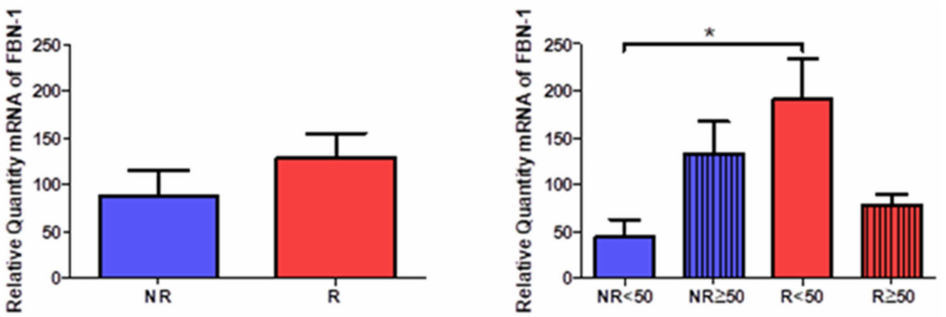
Figure 13. Protein expression of fibulin 5 in NR < 50 ( A ), NR ≥ 50 ( B ), R < 50 ( C ) and R ≥ 50 ( D ).